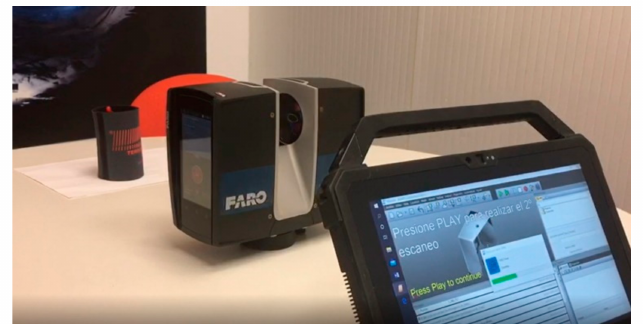
Figure 14. Scanner and tablet used in the SHOTCRETE